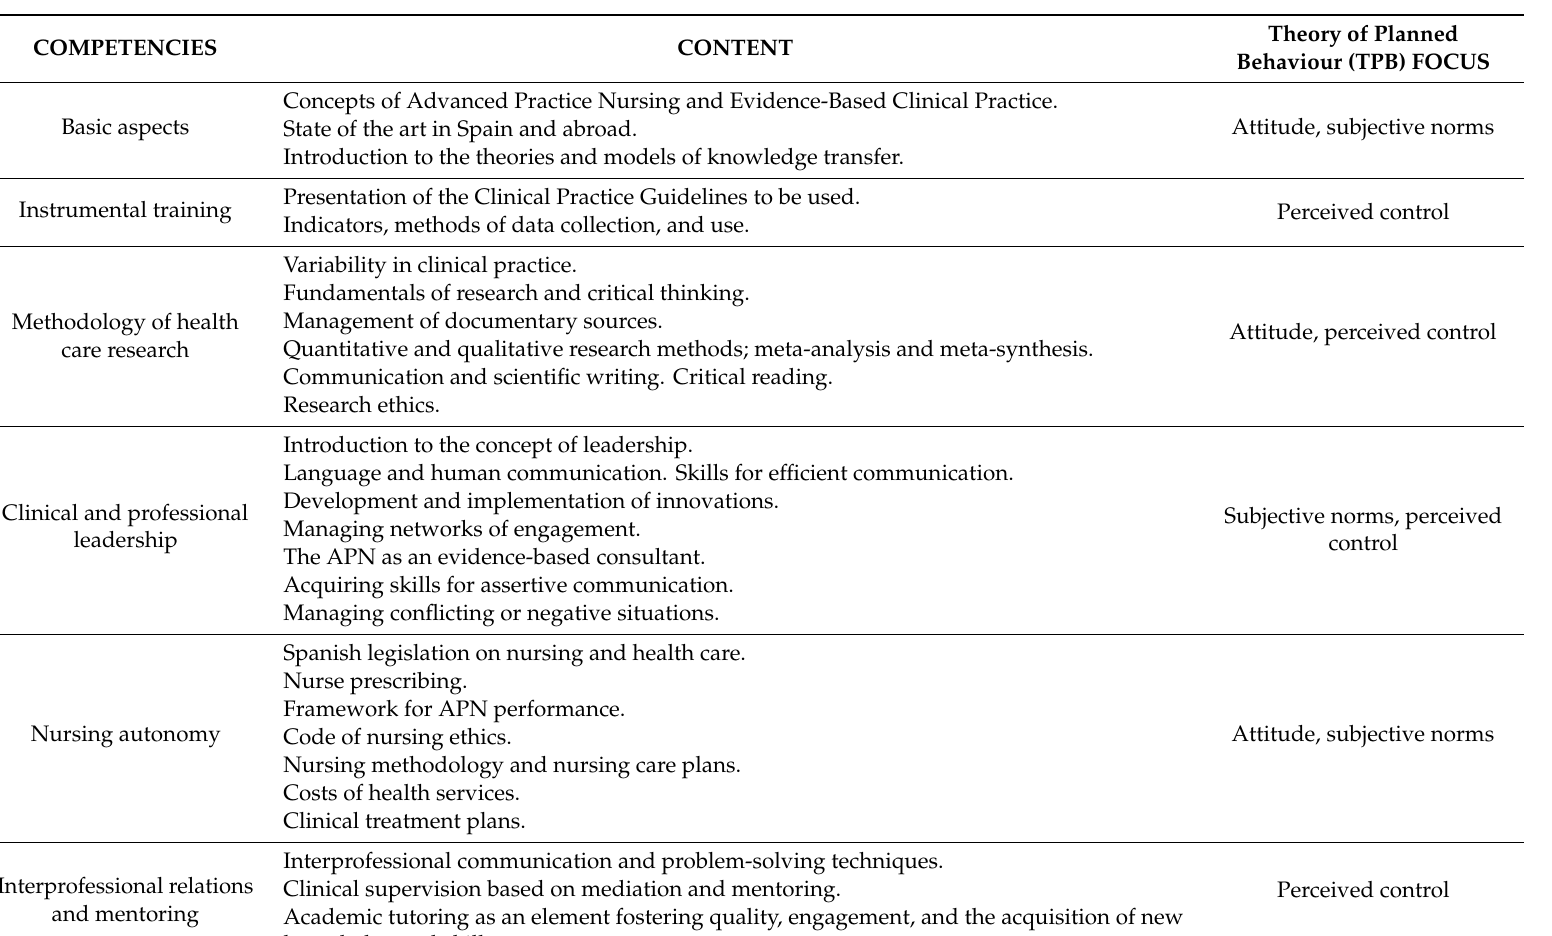
Table 1. Training programme for Advance Practice